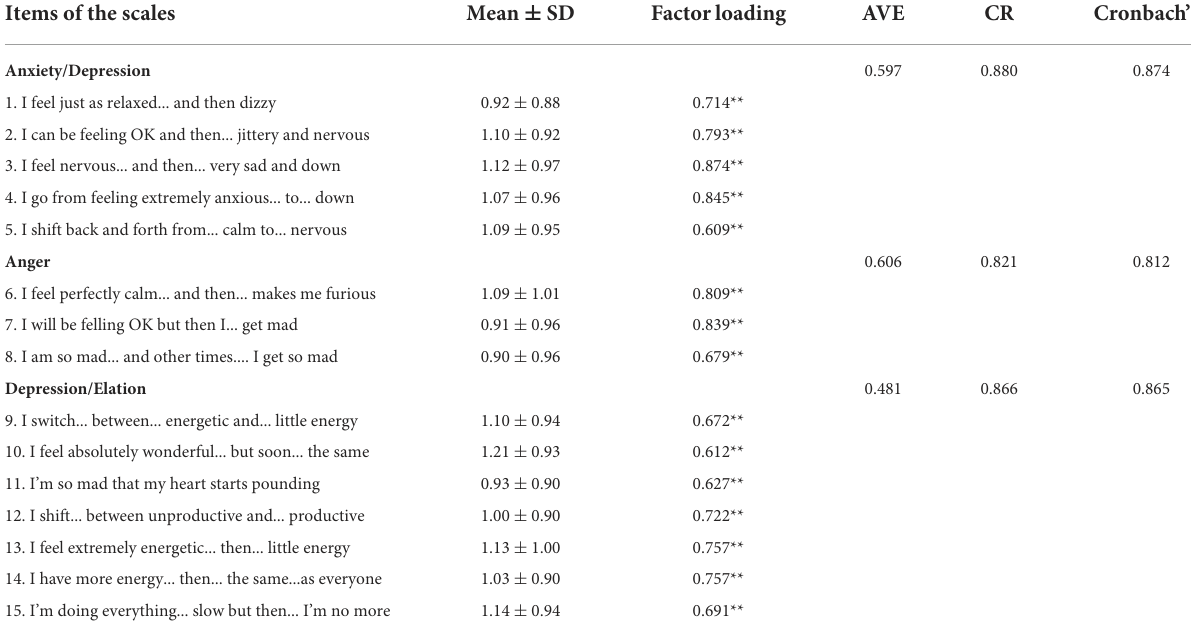
TABLE 4 Mean ± SD, reliability and convergent validity for the ALS-AF ( n = 1,439). Items of the